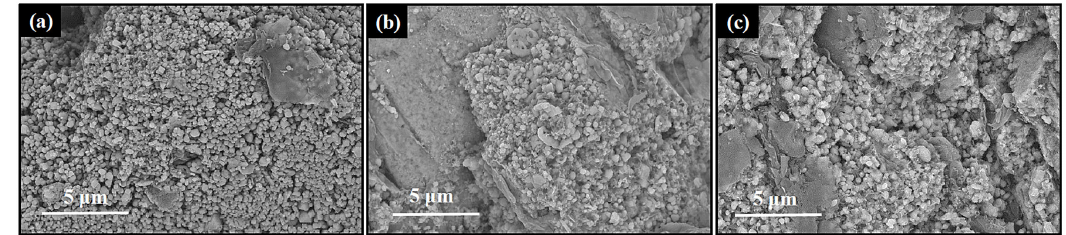
Figure 6. Morphology of product MgAl 2 O 4 in MgO ‐ C ‐ Al 4 SiC 4 system reacted at different temperature: ( a ) 1400 °C; ( b ) 1500 °C and ( c ) 1600 °C.